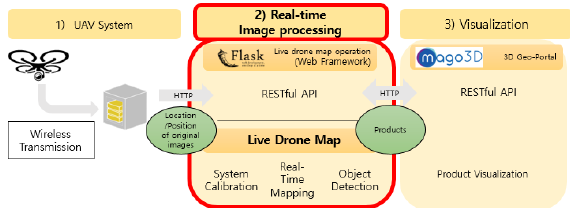
Figure 1. The architecture of real-time platform process diagram for marine surveillance